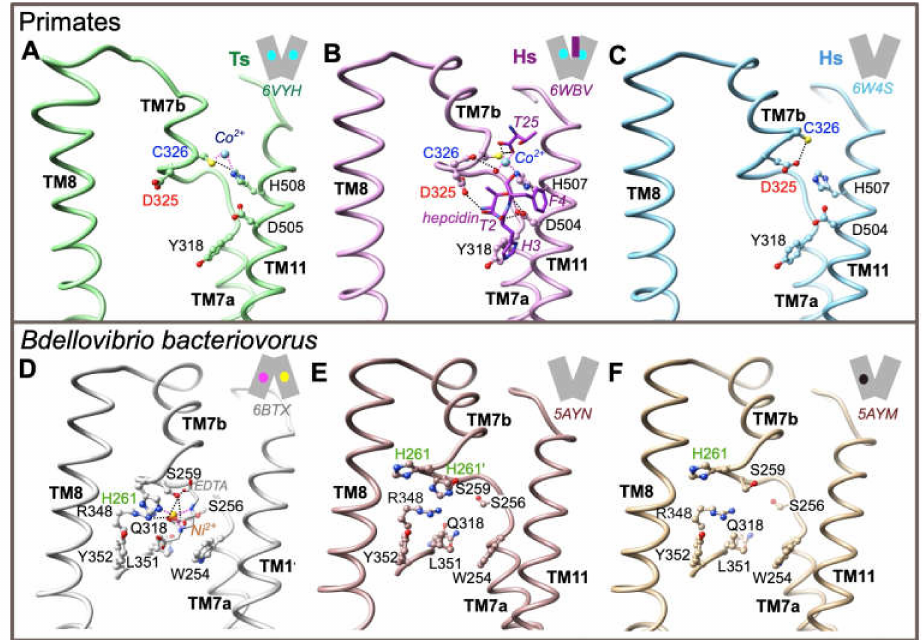
Figure 3. Environment of the ion-binding site at the level of C-lobe TM7b in both the BbFpn and HsFPN1/TsFpn 3D structures. All the considered 3D structures are in an outward-facing conformation ( A – C , E , F ), except for BbFpn in complex with Ni 2+ and EDTA (inward-facing state- E ). PDB codes are indicated for each of the represented structures. Two possible conformers are shown for His261 in the BbFpn 3D structure in panel E. H-bonds and salt-bridges are shown with dashed